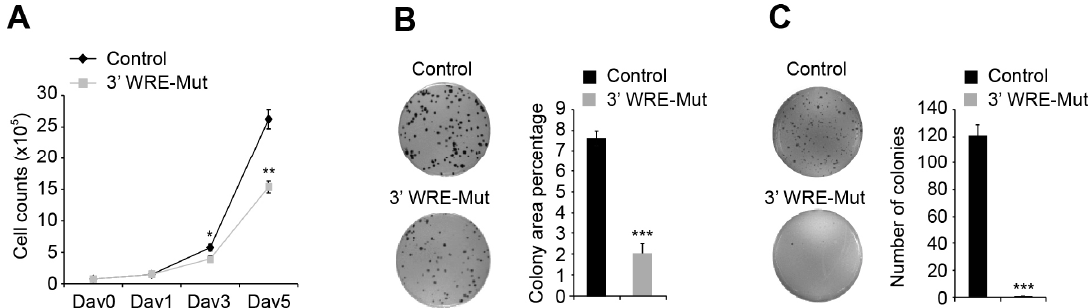
Figure 5. The MYC 3 ′ WRE controls cell proliferation and clonogenic growth. ( A ) Cell proliferation analysis of control and 3 ′ WRE ‐ Mut cells on days one, three, and five after plating (day 0); ( B ) clonogenic growth of control and 3 ′ WRE ‐ Mut cells on a plastic substrate. The percentage of area occupied by the colonies was quantified using ImageJ software 10 days after plating; ( C ) anchorage-independent growth of control and 3 1 WRE-Mut cells. Colony formation was quantified using ImageJ software 21 days after plating. Error bars are ˘ SEM (* p < 0.05, ** p < 0.01, *** p < 0.001).